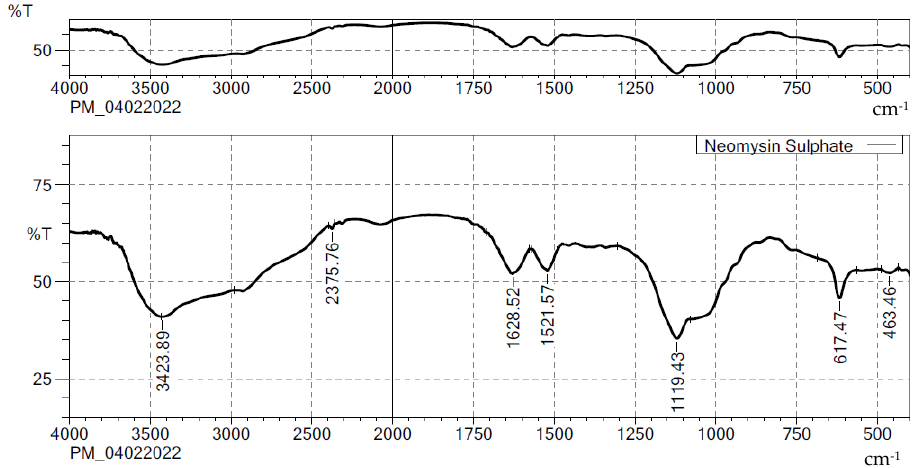
Figure 1. FTIR spectra of NES.